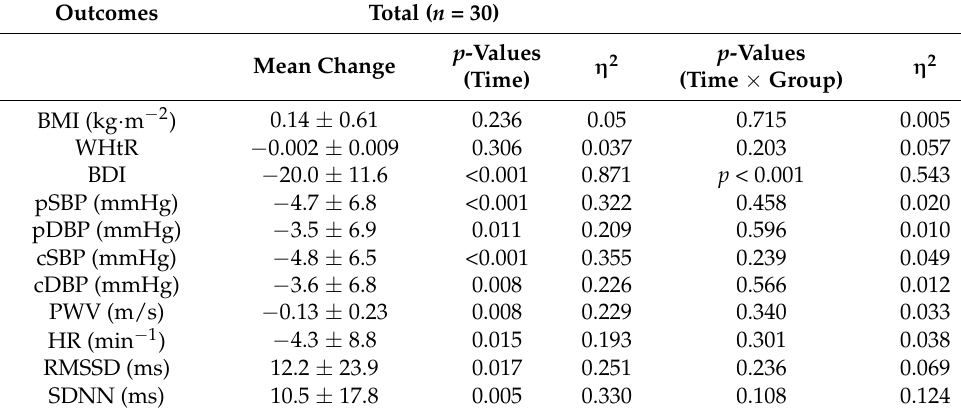
Table 2. Descriptive and inferential statistics of